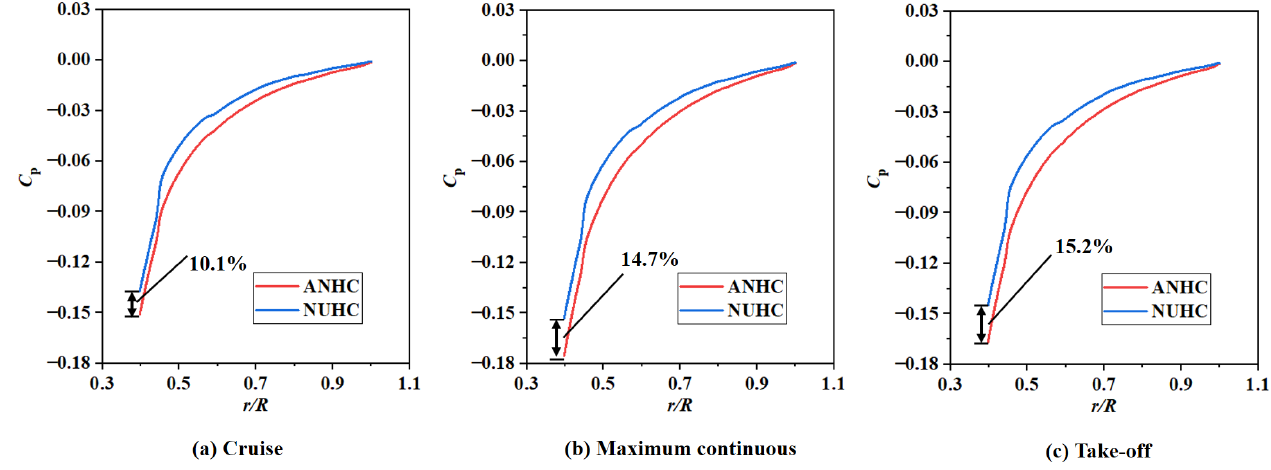
Figure 22. Pressure coefficient distributions of rotating disk surface under ANHC and NUHC.